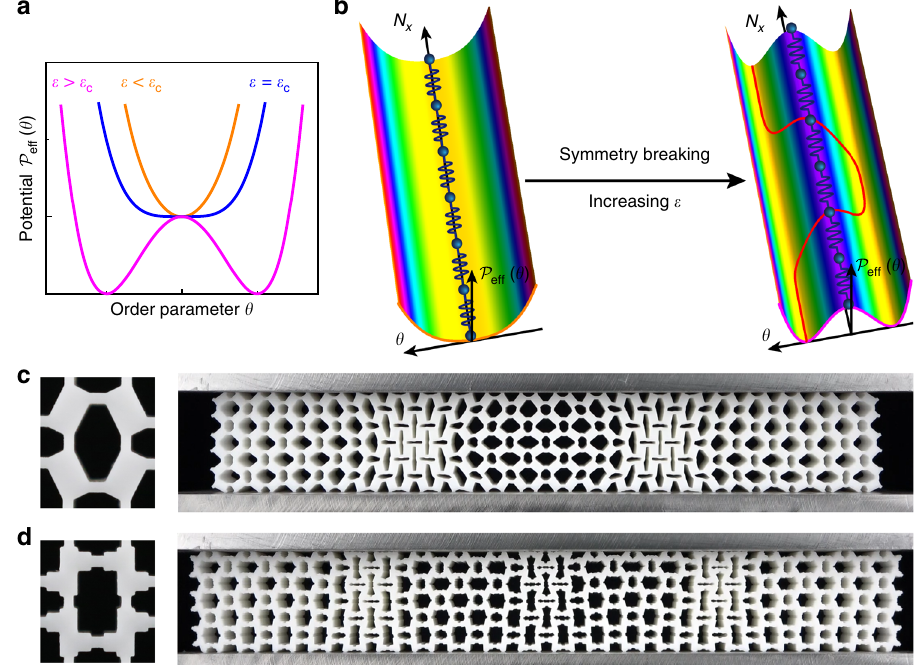
Fig. 5 Programming periodic localizations in 2D metamaterials based on the general framework. a , b Illustrations of the evolution of the effective on-site potential with compressive strain, and the structural phase transition mechanism of the multistable systems. This general framework identi fi es the mechanism and provides the guideline for exciting static periodic solitons in metamaterials. c , d Unit cells and periodic localizations underlying the static kink/antikink excitations in Block-Spring and Rod-Spring metamaterials, respectively. The deformed con fi gurations are shown at a compressive strain ε ¼ 9 : 5 % . The architectures of the unit cells, and comparisons among the experimental, numerical and theoretical results of these metamaterials are shown in detail in the Supplementary Figs. 10 –